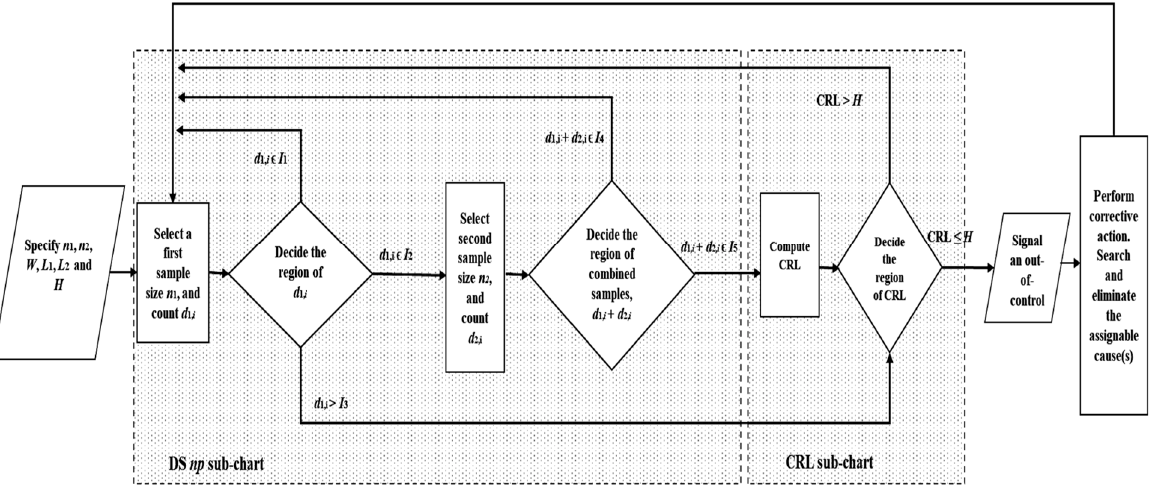
Figure 2. The operational flow chart for the SDS np chart.